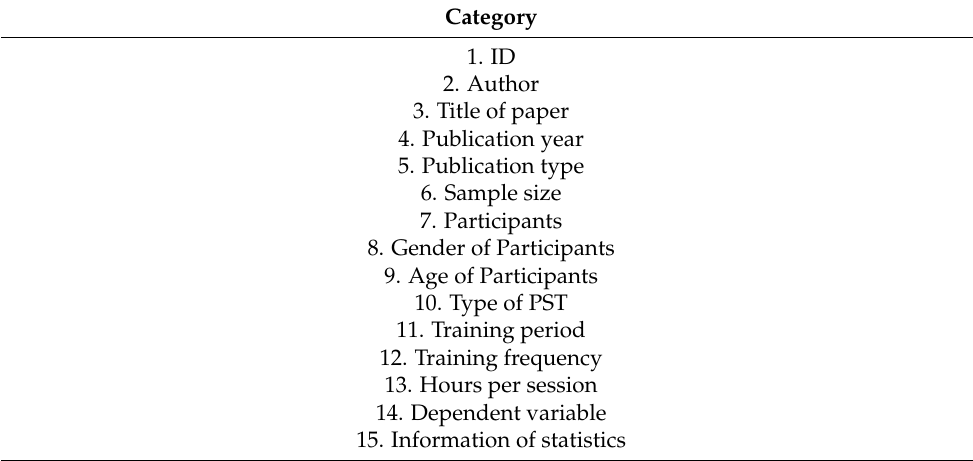
Table 2. Example of the coding